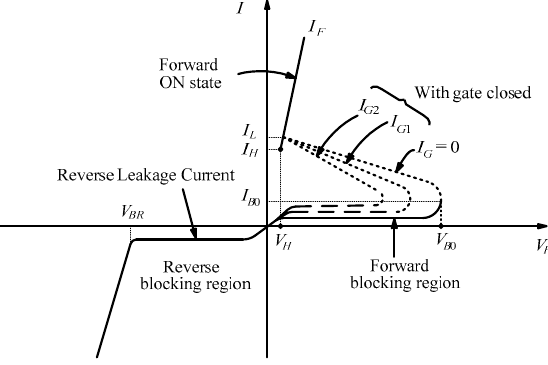
Figure 2. Different kind of SCR Static I-V Characteristics (qualitative representation, not in scale). Legend: V B0 = Forward Breakover Voltage, V BR = Reverse Breakover Voltage, I G = Gate Current, I L = Latching Current, I H = Holding Current.